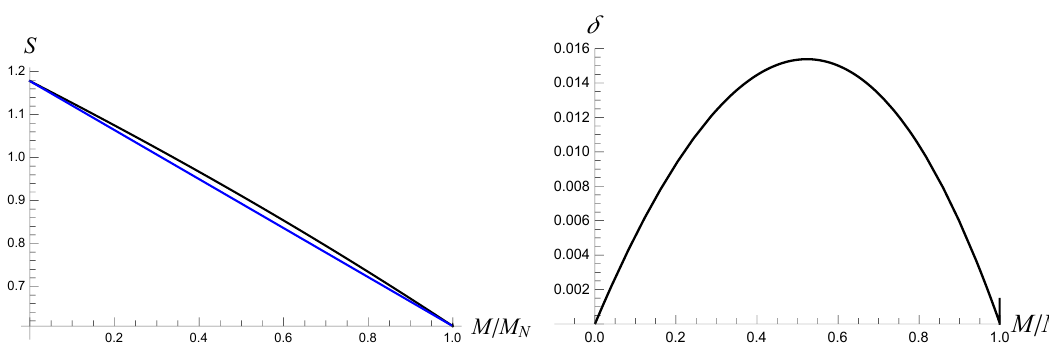
Figure 10 . Left : total generalized entropy (black) and its linear fit (blue). Right : difference δ between the total generalized entropy and the linear fit. Here we have set ν = 1 / 3